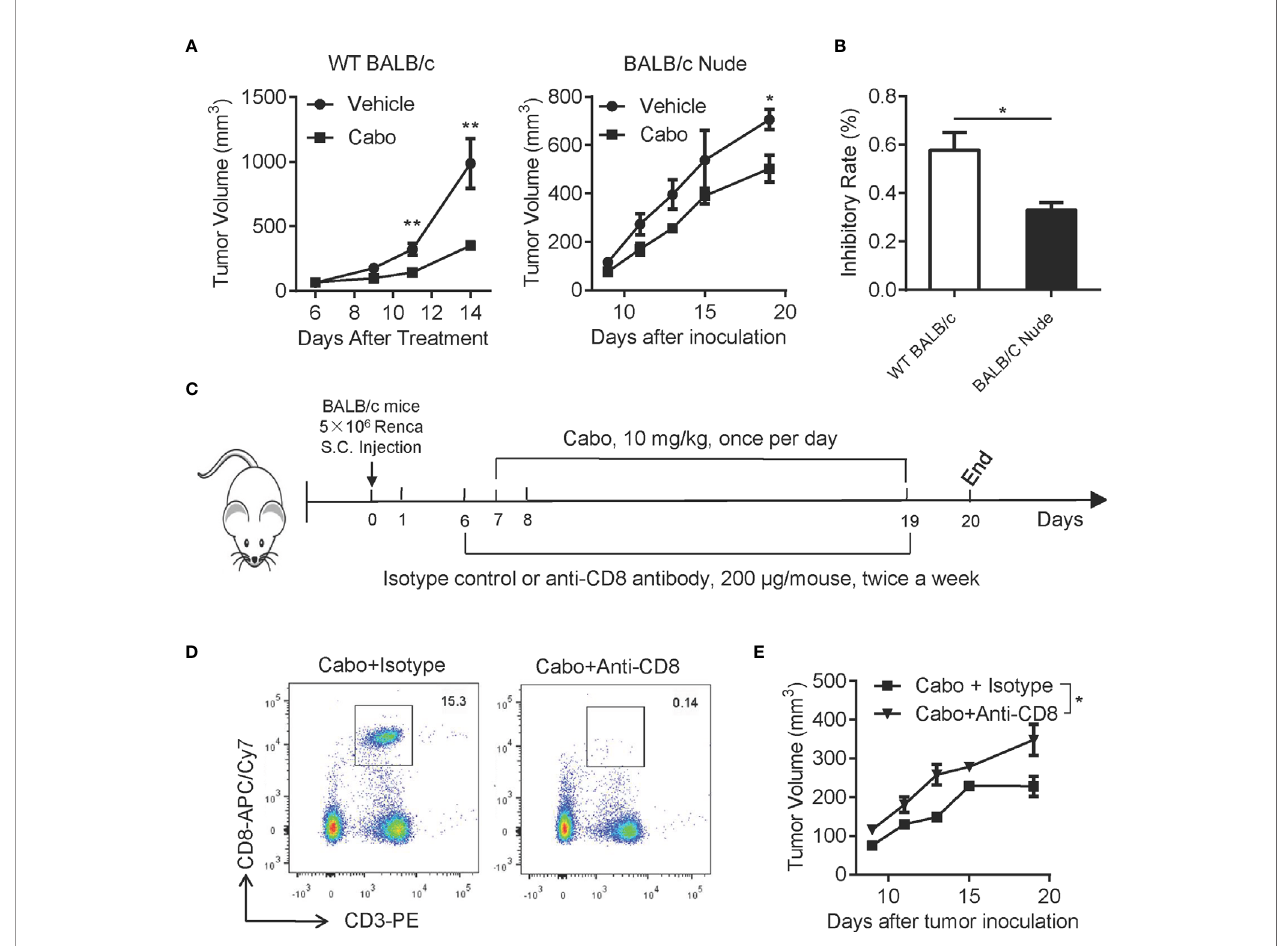
FIGURE 6 | CD8 + T cells are required for cabozantinib-induced inhibition of tumor growth. (A) Tumor growth inhibition by cabozantinib in wild type (WT) BALB/c and BALB/c Nude mice. 5×10 6 Renca cells were subcutaneously inoculated into the right fl ank of WT BALB/c and BALB/C Nude mice. Seven days after tumor inoculation, mice (n=5 per group) received either vehicle or cabozantinib (10 mg/kg, once per day by gavage) treatment for 13 days. (B) Tumor growth inhibition rates by cabozantinib treatment in WT BALB/c and BALB/c Nude mice. This experiment was repeated 3 times. The results of one representative experiment are shown. (C) Schematic diagram of the experimental design. Mice were subcutaneously inoculated with Renca cells (day 0). At day 6 (one day before cabozantinib treatment), mice were randomly assigned to 4 groups (n=6 for each group) and received antibodies treatment as indicated: vehicle + isotype, cabozantinib + isotype control, vehicle + anti-CD8-depleting antibody and cabozantinib + anti-CD8-depleting antibody. (D) Representative FACS plot showing CD8 + T cells in peripheral blood 24 hours after intraperitoneal injection of anti-CD8 depleting antibody. (E) The tumor growth curve of each group during treatment. This experiment (C-E) was repeated 2 times. The results of one representative experiment are shown. * P <0.05, ** P <0.01, by unpaired t-test; ns, not signi fi